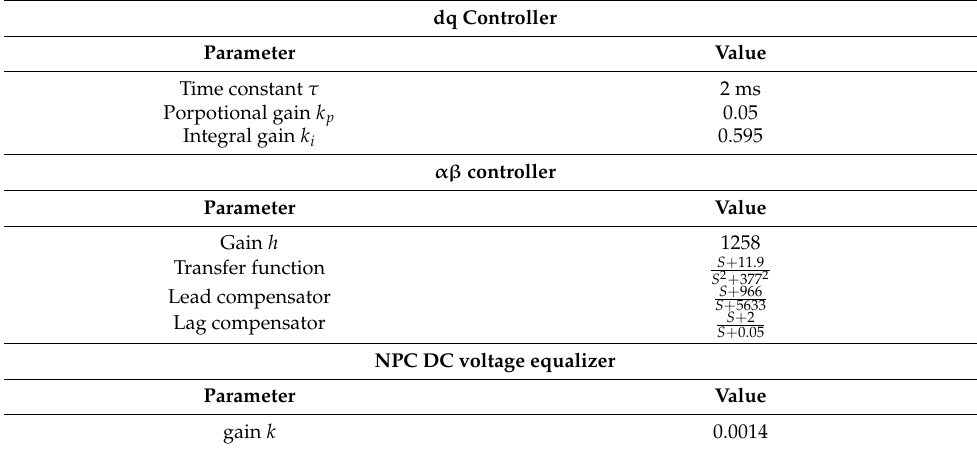
Table 2. Controller